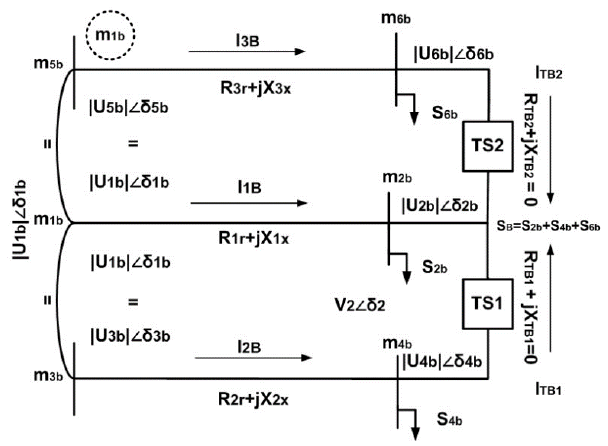
Figure 2. The electrical equivalent diagram of mesh distribution system under an ideal case.